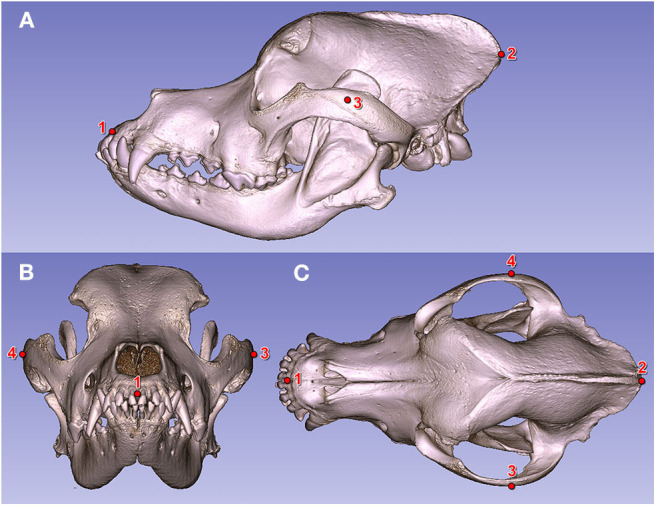
Fiducial markers on a Saint Bernard's skull (volume-rendered model). (A) Left lateral view. (B) Rostral view. (C) Dorsal view. (1) Prosthion. (2) Inion. (3) Widest point of the left zygomatic arch. (4) Widest point of the right zygomatic arch.